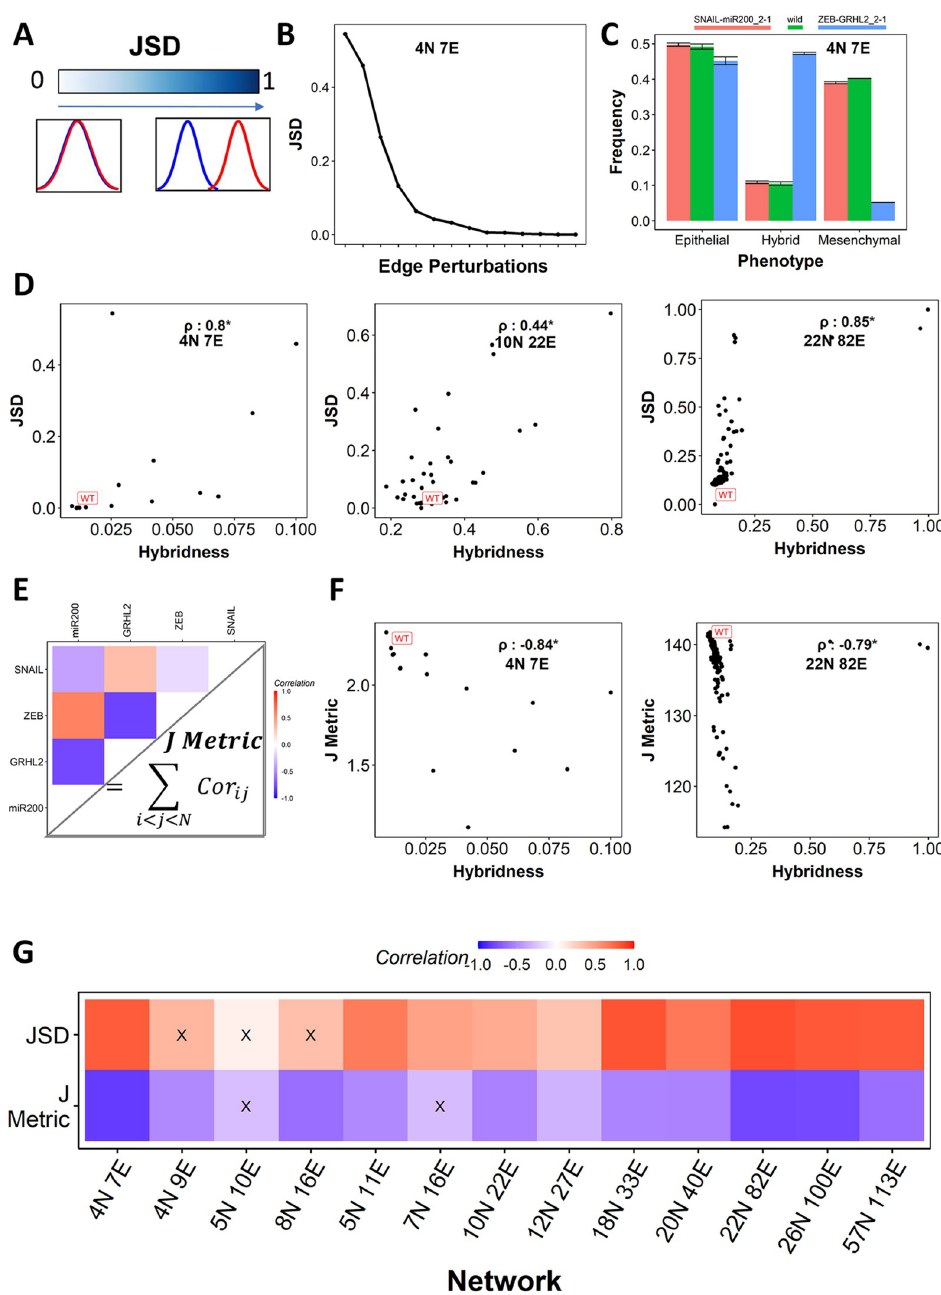
Fig 2. Change in global expression patterns correlates with the change in hybridness. (A) Depiction of JSD as a measure of distance between two frequency distributions. (B) JSD values were obtained for the single edge perturbation networks of the 4N 7E EMP network. The edge perturbation indices are given in S1 Table. (C) Bar plot showing the frequency of Epithelial, Mesenchymal, and Hybrid phenotypes for WT 4N 7E EMP network, perturbation with least JSD (Snail-miR200-2-1), and perturbation with highest JSD (ZEB-GRHL2-2-1). (D) Representative scatter plots between JSD and Hybridness for (i) 4N 7E, (ii) 10N 22E, and (iii) 22N 82E. Each point corresponds to one perturbation. Spearman correlation coefficient is reported. (E) Depiction of J metric calculation with the example of 4N 7E network correlation matrix. (F) Representative scatter plots between J metric and Hybridness for (i) 4N 7E and (ii) 22N 82E. Spearman correlation coefficient is reported. (G) Spearman correlation between hybridness and JSD (top row) and J metric (bottom row). “X” represents p-value > 0.05. � : p-value < 0.05.